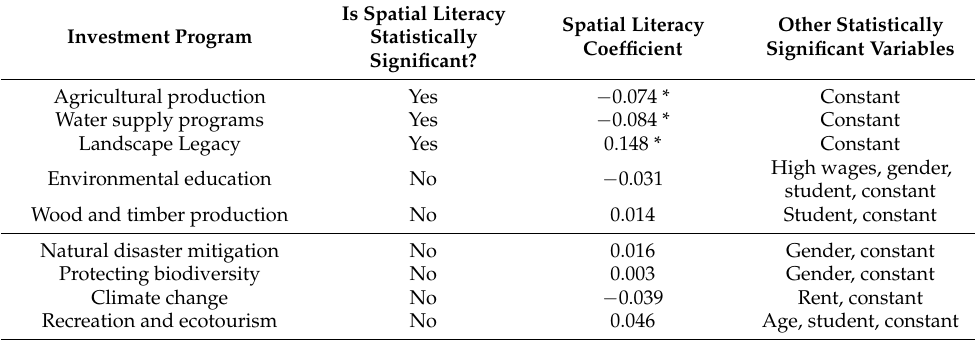
Table 4. Empirical results for the Ordinary Least Squares model of investment preferences, not controlling for whether an individual selects a given category or not. The results reflect the aggregate effect of category selection and magnitude selection.